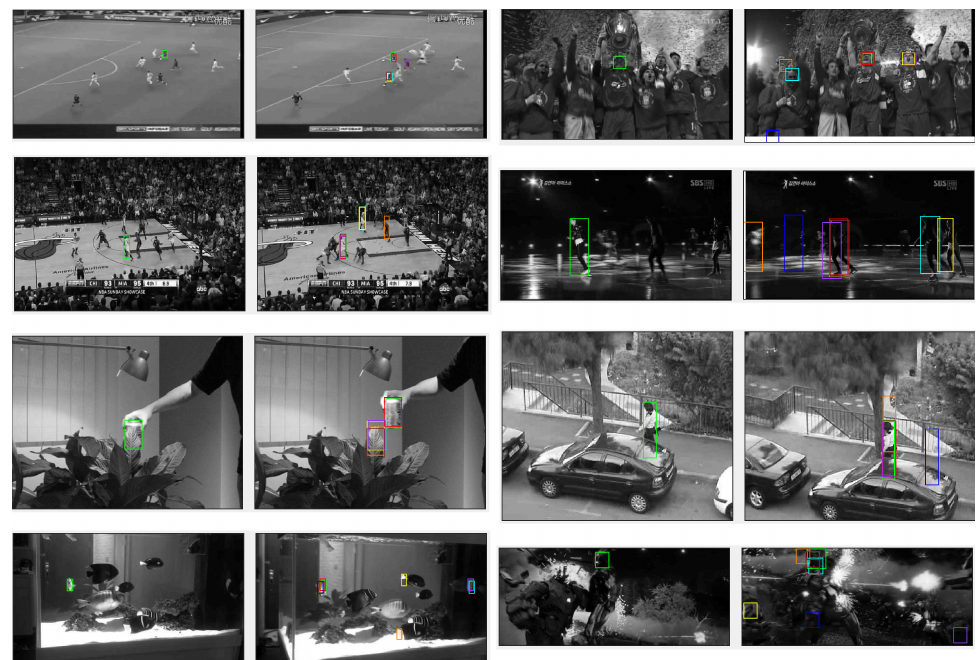
Figure 6. Comparison performance of different methods using the proposed feature extraction method. The colour boxes indicate the template location defined by: Ground truth BBS CoTM DDIS DIM NCC QATM SSD ZNCC. Note that the colour images have been converted to greyscale in order to make the bounding boxes more visible. The boxes predicted by ZNCC and NCC are remarkably similar, and thus